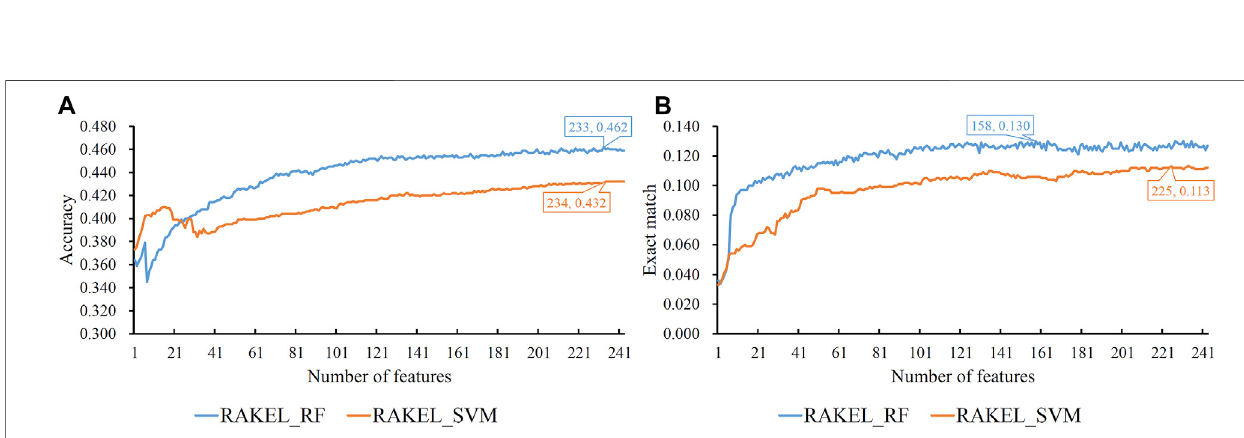
FIGURE 6 | IFS curves on linkage features using different classi fi cation methods. (A) Accuracy is set to the Y -axis (B) Exact match is set to the Y -axis. RAKEL_RF/ RAKEL_SVM indicates that RAKEL with RF/SVM as the base classi fi er is used to construct the multi-label classi fi